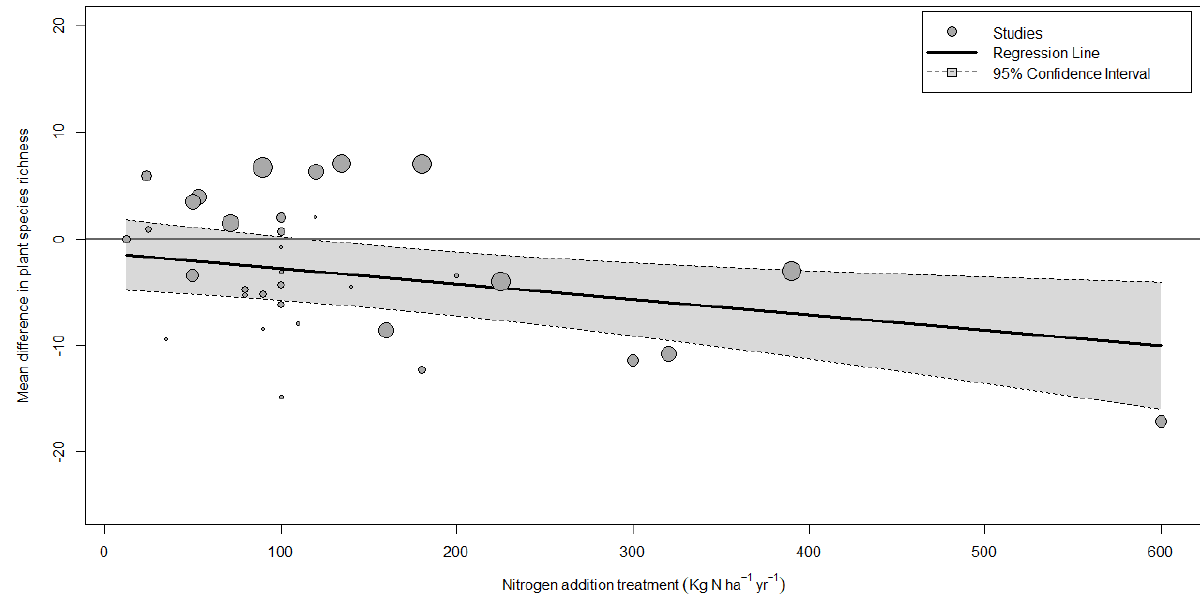
Figure 3. Mean difference in plant species richness in response to 34 different levels of nitrogen addition compared to zero-nitrogen controls reported by 14 studies included in a meta-analysis. Symbol size is a function of the weight in the model, with larger studies having a greater weight on model